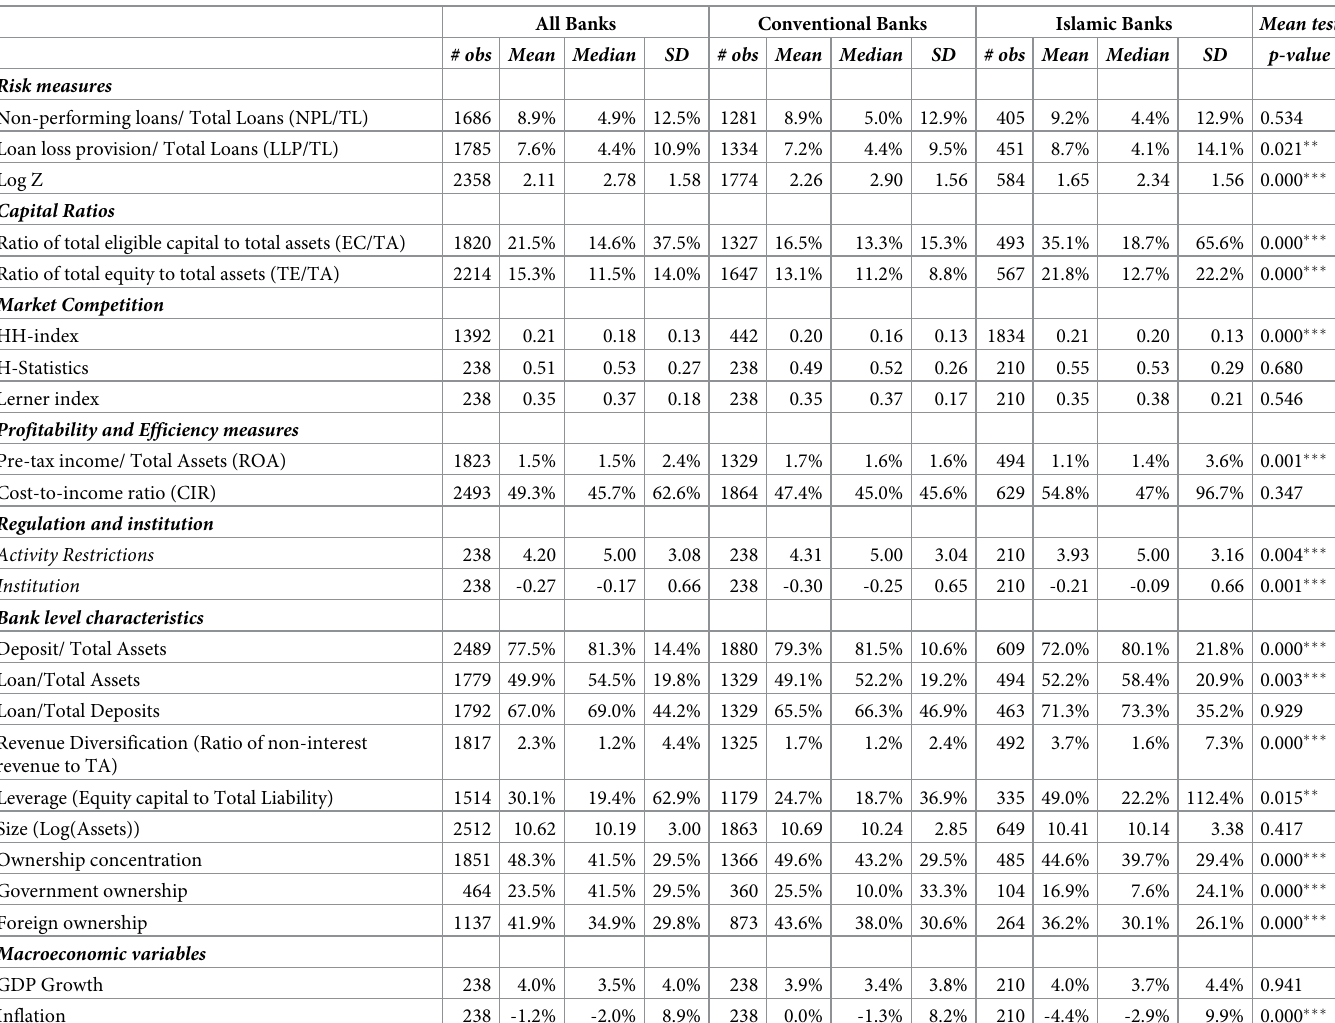
Table 2. Descriptive statistics of sample